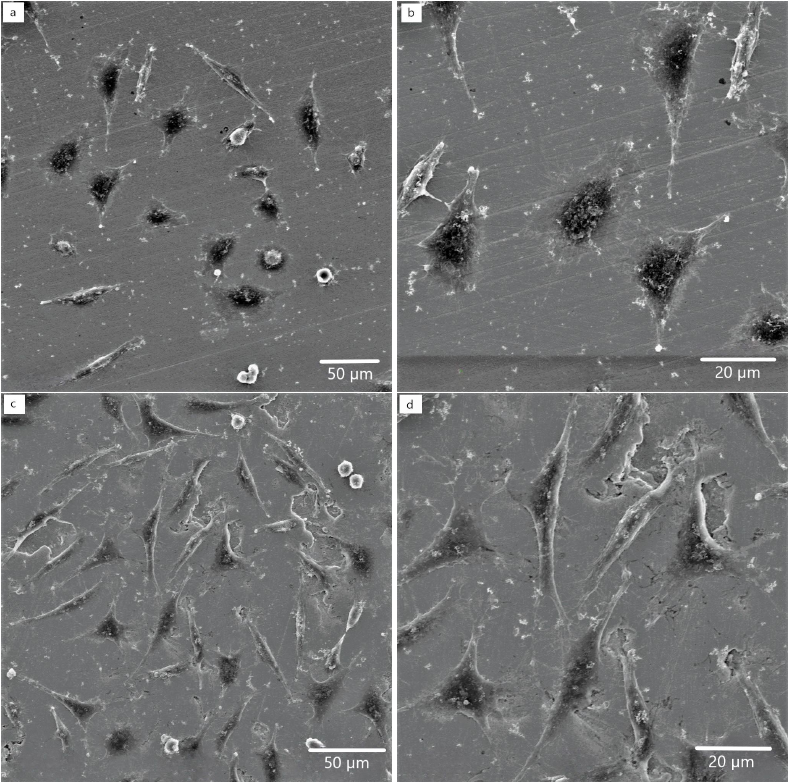
Figure 6. SEM images taken from 316L investment casting sample after cell growth test ( a ) 1 day, × 500, ( b ) 1 day, × 1000, ( c ) 3 days, × 500, ( d ) 3 days, ×